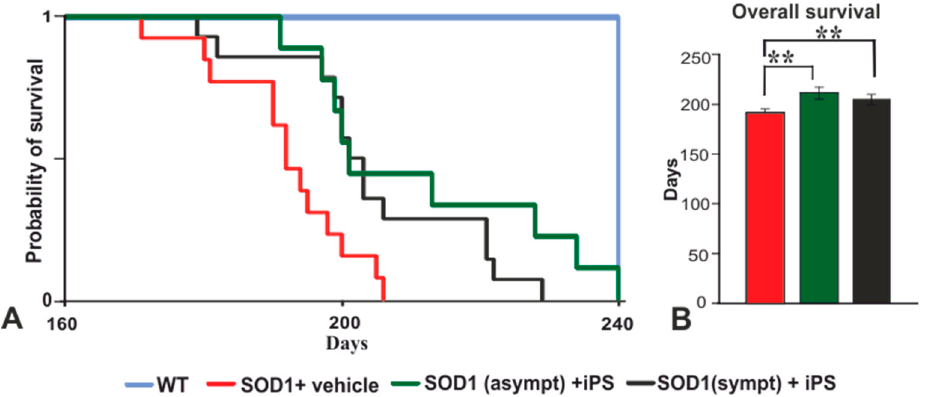
Figure 3. Animal survival . Kaplan–Meier plot describes the cumulative probability of animals’ survival in tested Tg and WT groups ( A ). NP-iPS cell therapy significantly extended the survival of both cell-transplanted groups ( B ). Differences in the groups were analyzed by one-way ANOVA, p < 0.01